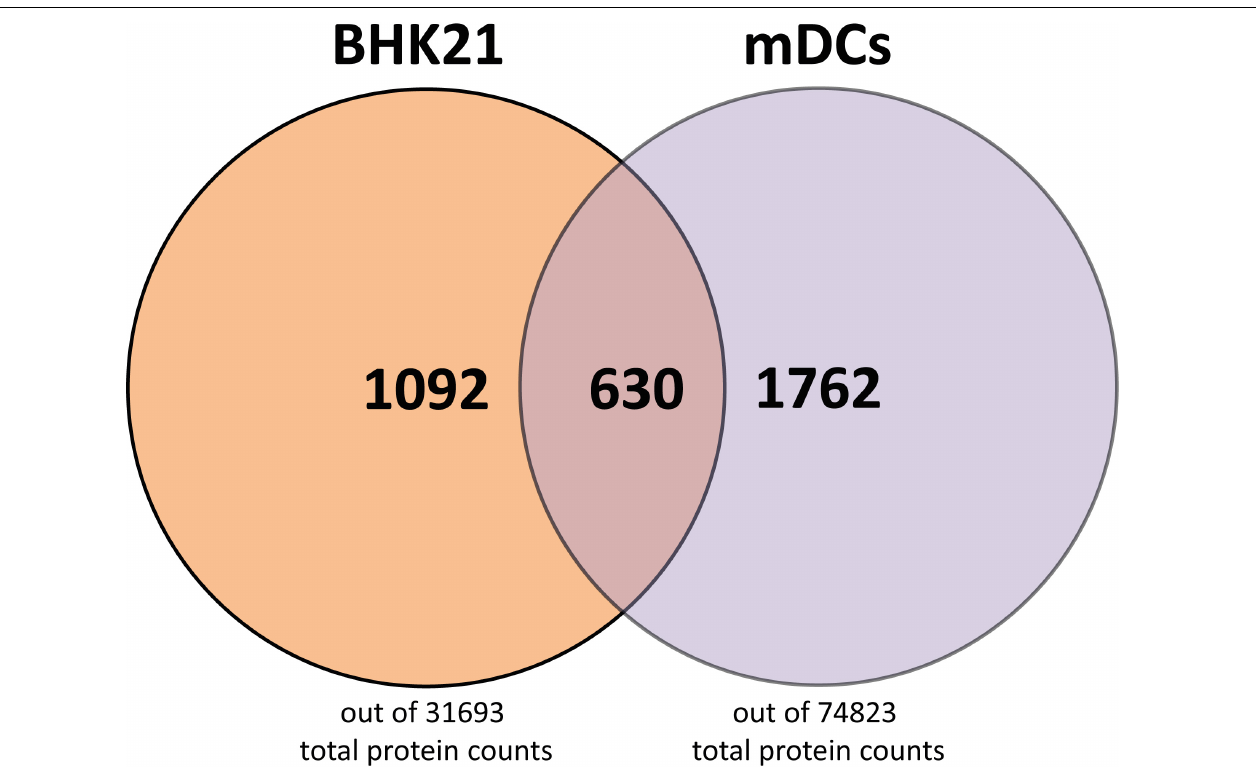
FIGURE 6 | Host cell proteins in L- and H-particles derived from BHK21 cell and L-particles derived from mDCs. A total number of host cell proteins of 1092 were found in H- and L-particles from HSV-1-infected BH21 cells, whereas 1762 host cell proteins were detected in L-particles derived from HSV-1-infected mDCs. 630 host cell proteins were identical in the HSV-1 particles derived from these different cell types. Data is evaluated based on the databases from Mesocricetus auratus (BHK21 cells) and Homo sapiens